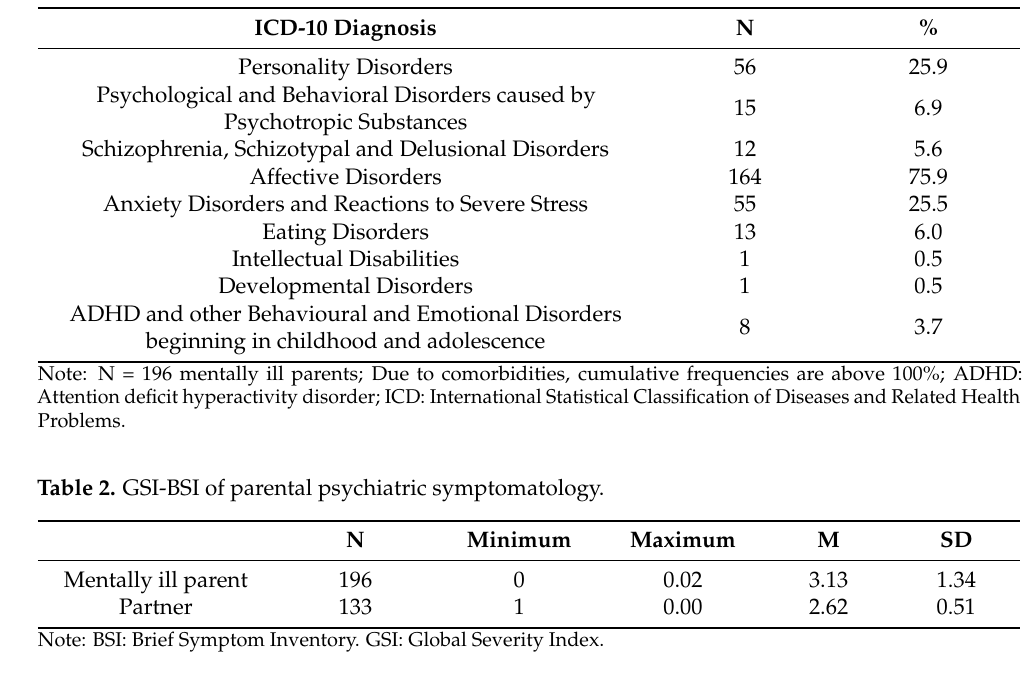
Table 3. Children’s psychiatric symptomatology reported by the mentally ill parent as well as